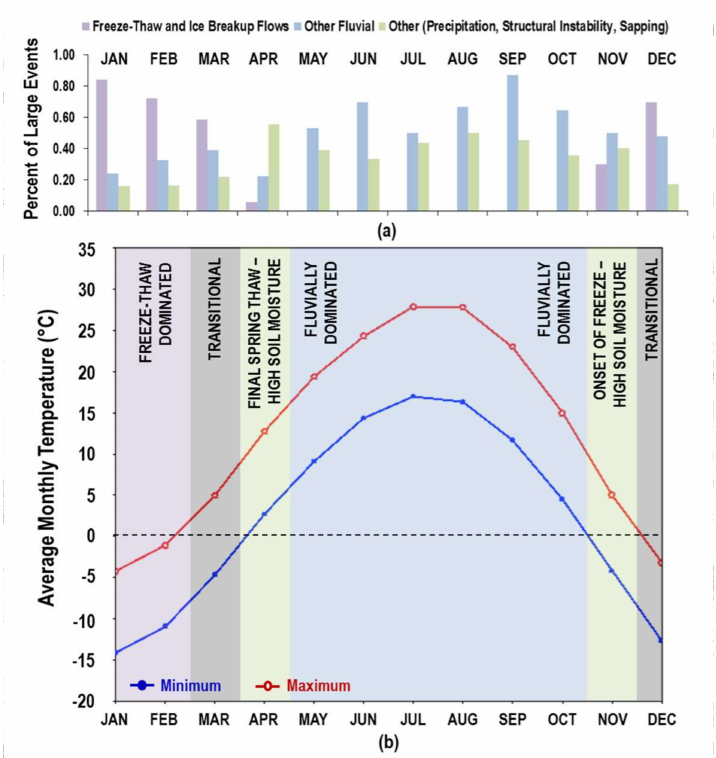
Figure A3. (a) Percent of large events likely triggered by freeze–thaw and ice breakup floods (purple), other ice-free floods (blue), and other processes including precipitation, structural instability, and seepage/sapping (green), based on qualitative photographic interpretations. Total number of observations: 347 events. Monthly percentages do not sum to 1 because some events were triggered by multiple processes and for some events, the cause of failure could not be determined; (b) average monthly maximum (red) and minimum (blue) temperatures based on long term mean (1981–2010), 4 × daily temperatures measured 2 m above the land surface for Good Thunder, MN. Temperature data from NCEP-NCAR Reanalysis 1. Dashed line indicates 0 ◦ C. Months binned by interpretations made in Section